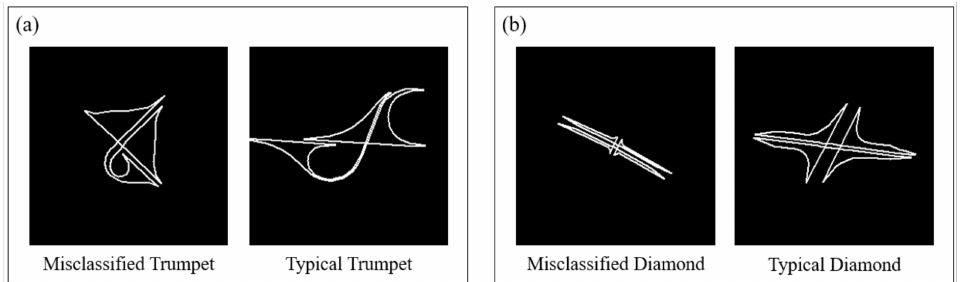
Figure 9. Some misclassified junctions and the typical junctions of their types: ( a ) misclassi- fied and typical Trumpet-type junctions, respectively, ( b ) misclassified and typical Diamond-type junctions, respectively.